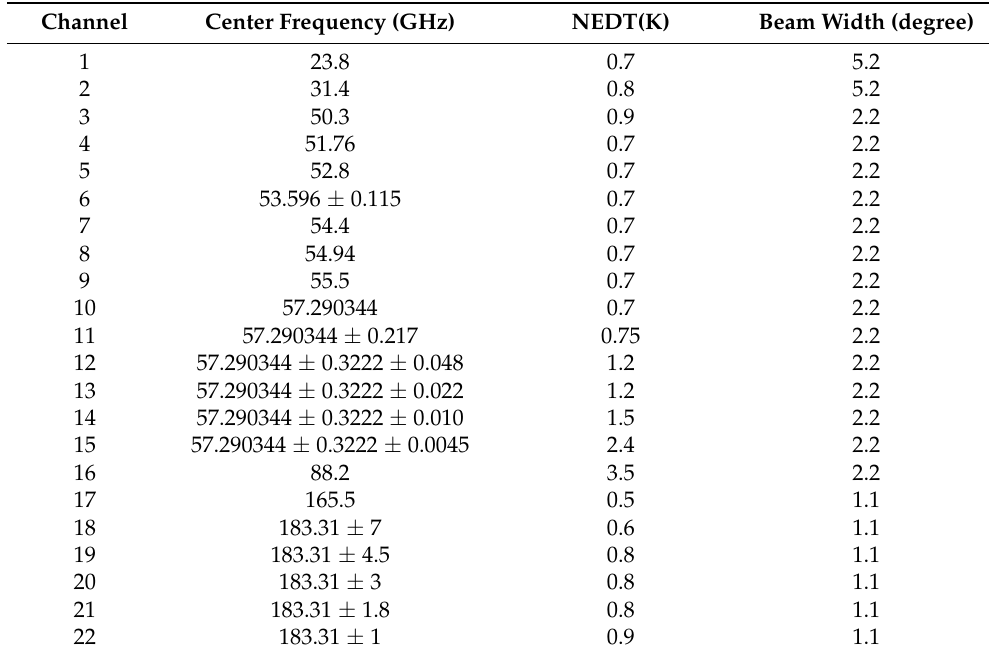
Table 1. ATMS instrument